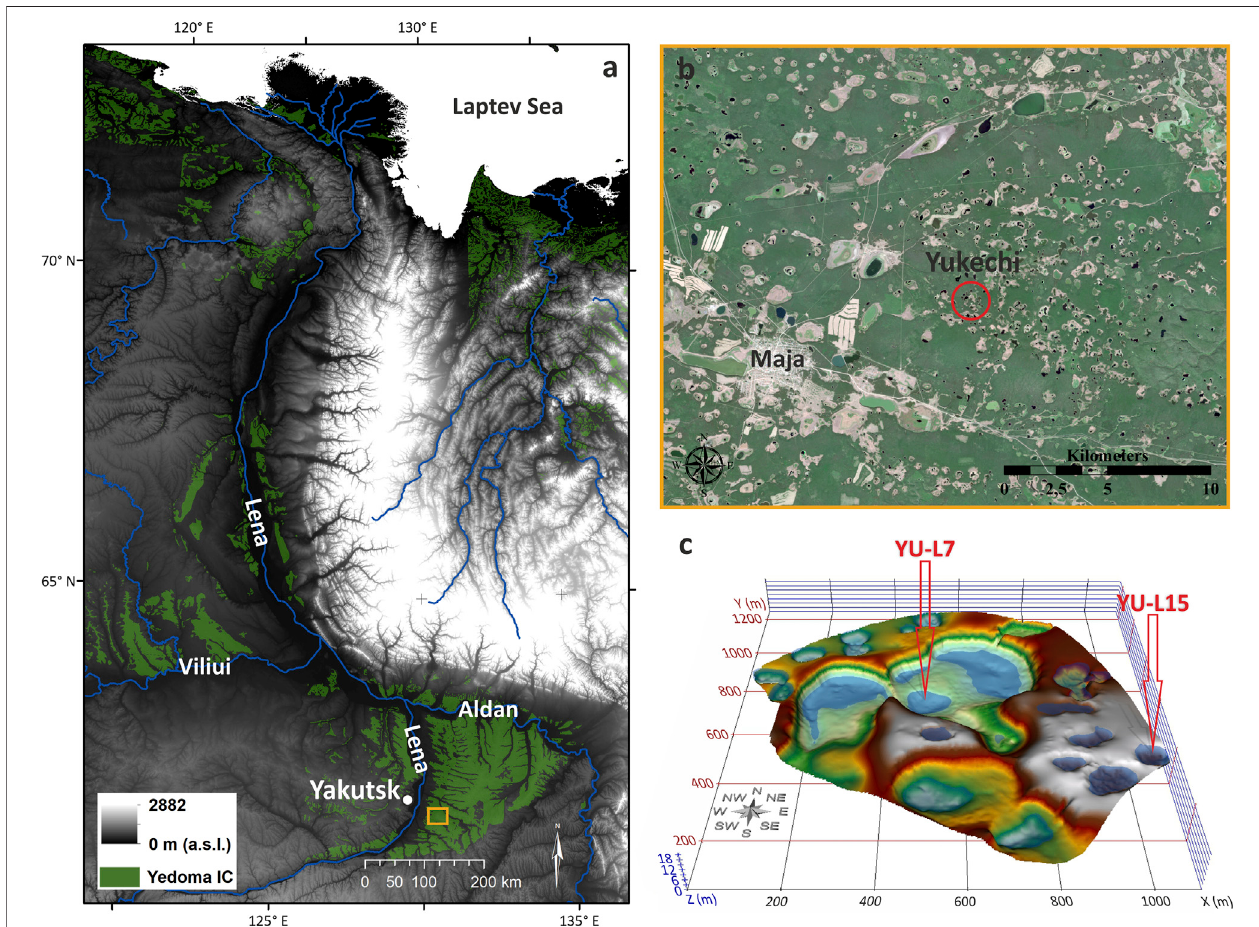
FIGURE 1 | Overview of the study area in Central Yakutia, Russia. (A) Location of the study area (orange square) near Yakutsk (Yedoma IC coverage after Strauss etal.(2016),DigitalElevationModel(DEM)generatedusingdatafromtheESADUEPermafrostProject(SantoroandStrozzi,2012). (B) CloseupoftheYukechistudysite withinthe typical Yakutian alas landscape (Sentinel-2 (ESA) 2017 – 07 – 29). (C) DEM with drilling locations on the alaslake (YU-L7) and theYedomalake(YU-L15). Height differences are obvious from the z-axis (Modi fi ed after Ulrich et al., 2017b).